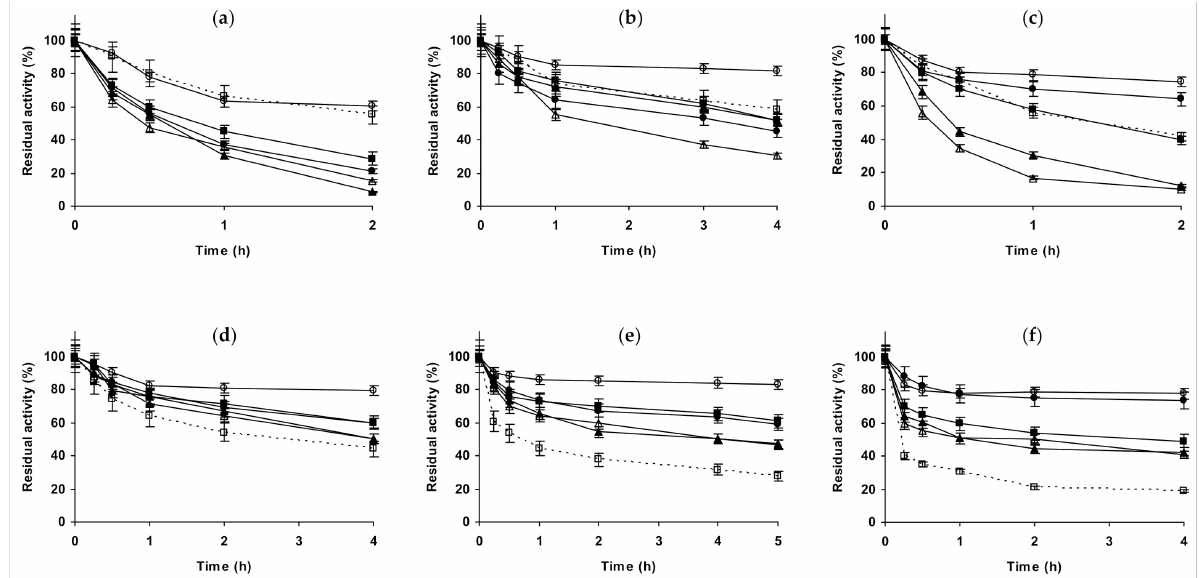
Figure 5. Effect of ionic strength and inactivation pH on the stability of different immobilized preparations of EVT. Octyl- EVT: ( a ) pH 5.0 and 77 ◦ C; ( b ) pH 7.0 and 75 ◦ C; ( c ) pH 9.0 and 73 ◦ C. Glutaraldehyde-EVT: ( d ) pH 5.0 and 75 ◦ C; ( e ) pH 7.0 and 76 ◦ C; ( f ) pH 9.0 and 68 ◦ C. Other specifications are described in the Methods section. Dotted line, empty squares: references; full triangles: 1 M NaCl; empty triangles: 3 M NaCl; full circles: 1 M (NH 4 ) 2 SO 4 ; empty circles: 3 M (NH 4 ) 2 SO 4 and full squares: 1 M Na 2 SO 4